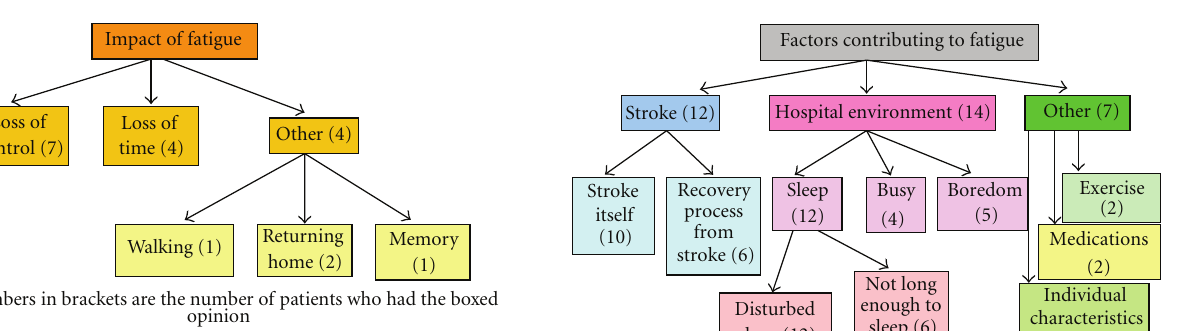
Figure 1: Impact of fatigue.